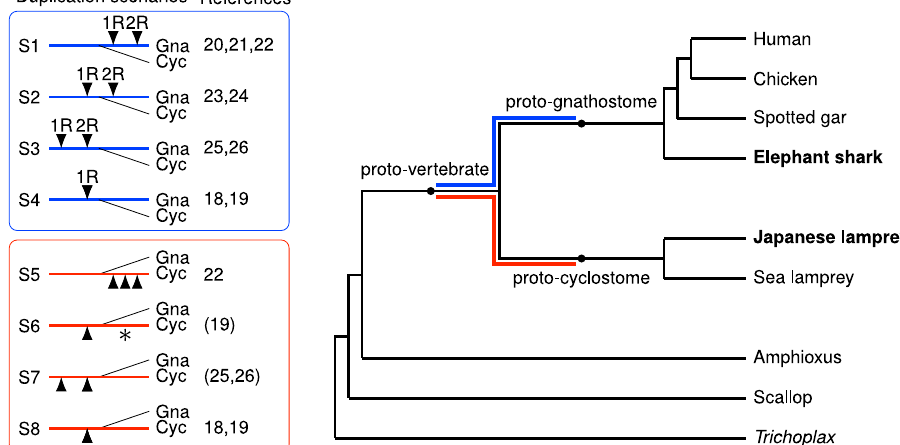
Fig. 1 Phylogenetic tree and previously proposed whole-genome duplication scenarios. Scenarios S1 – S4 show the proposed timing of tetraploidization events occurring in the interval between the proto-vertebrate genome and the proto-gnathostome genome. Scenarios S5 – S8 show polyploidization events between proto-vertebrate and proto-cyclostome. Triangles and asterisks indicate tetraploidization and hexaploidization events, respectively. The possibility of cyclostome-speci fi c hexaploidization (S6) was discussed brie fl y in ref. 19 . Reference 25 discussed the lack of clear evidence for cyclostome-speci fi c polyploidization, and ref. 26 reported the absence of recent polyploidization events in the cyclostome lineage (S7). References 18,19 argued that chromosome duplications and segmental duplications occurred after 1R (S4 and S8). Reference 24 suggested one shared tetraploidization before the gnathostome – cyclostome split and two lamprey-speci fi c tetraploidization events after the hag fi sh – lamprey split. It is presently considered that the hag fi sh and lamprey lineages share the same duplication history 27 , but this argument should eventually be con fi rmed by sequencing the hag fi sh genome. Few previous studies discussed both the timing of gnathostome-cyclostome split and the possibility of cyclostome-speci fi c polyploidization events, because cyclostome genomes were unavailable until recently. Gna gnathostome, Cyc